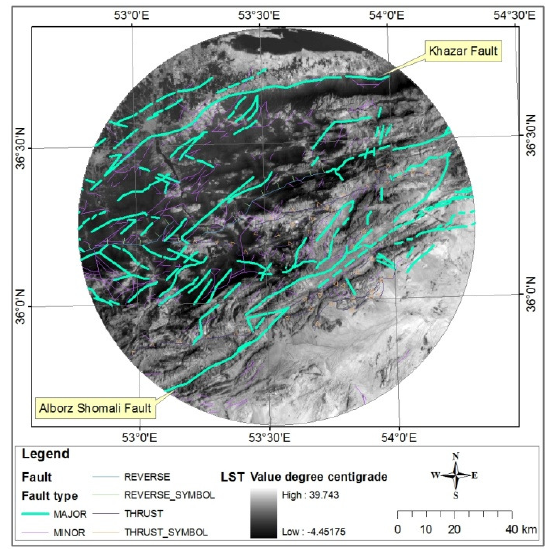
Figure 4: interpolated map of seismic activity by LPI method Overlaying the raster of earthquake magnitude and thermal classification, it has been revealed that as thermal pixel values decrease in a direction from southeast to northwest, the same trend can be observed in earthquake magnitude. The southeast portion of the area, as it can be seen in the Figure 1, Figure 2 and Figure 3, is high in both the thermal conditions and in seismic activity. Within the border of the study area about 29 earthquakes were recorded in a 40 years period. Up to 11 earthquakes with an average magnitude of 4.33 were recorded in the classes with higher thermal values and about 18 with average magnitude of 4.11 in classes with low thermal values. There may be some other factors that interfere in